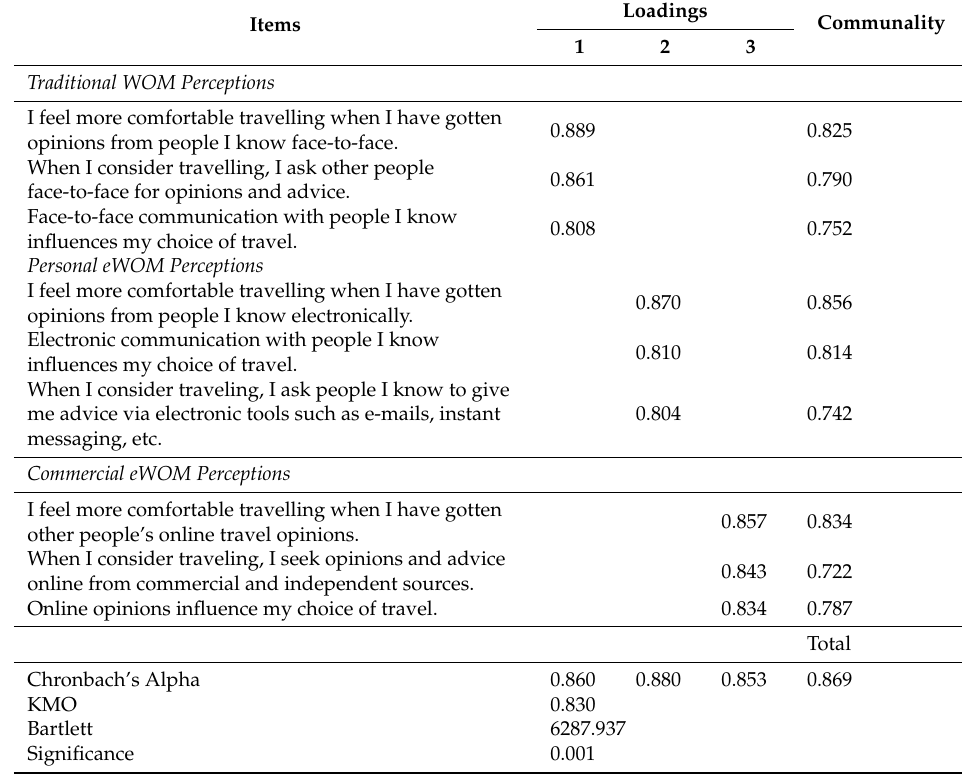
Table 2. Factor Analysis of Three Factors Solution for WOM Perceptions concerning travel to Bronson.